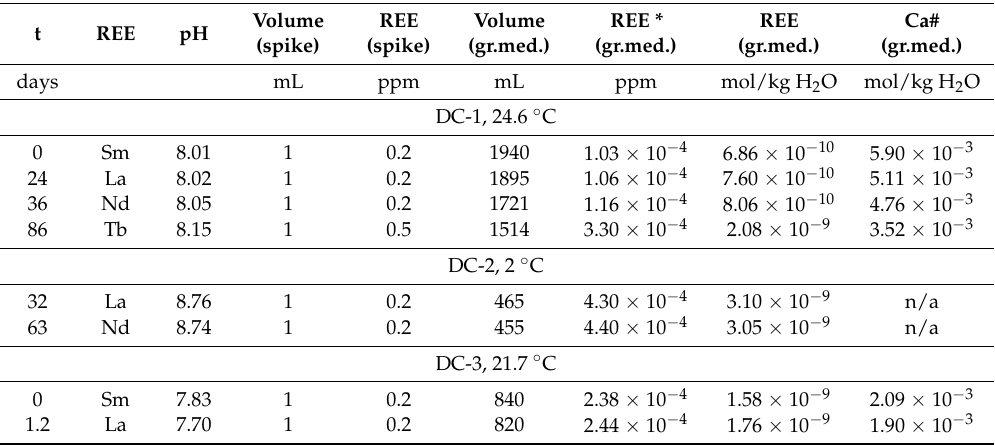
Table 1. Experimental setup and fluid data at the moment of REE addition.